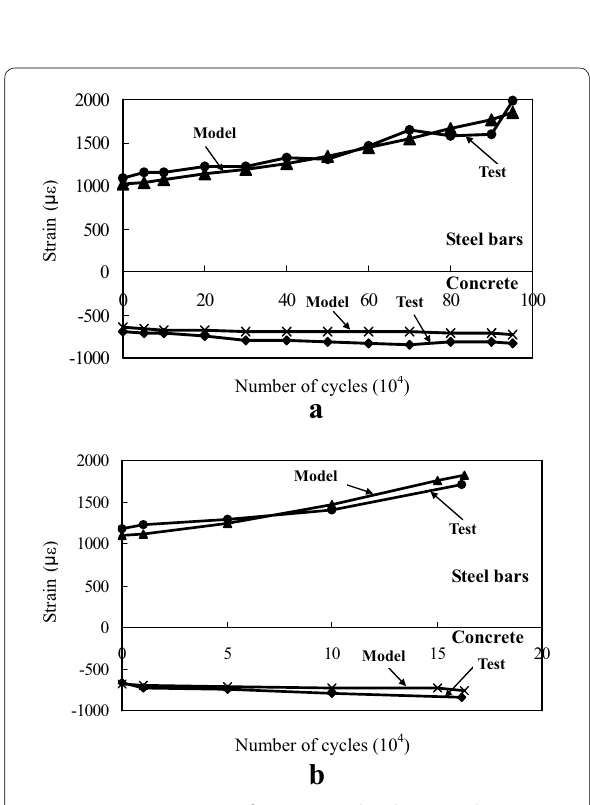
Fig. 10 Strain comparison of experimental and FPM results: a Beam 3 and b Beam